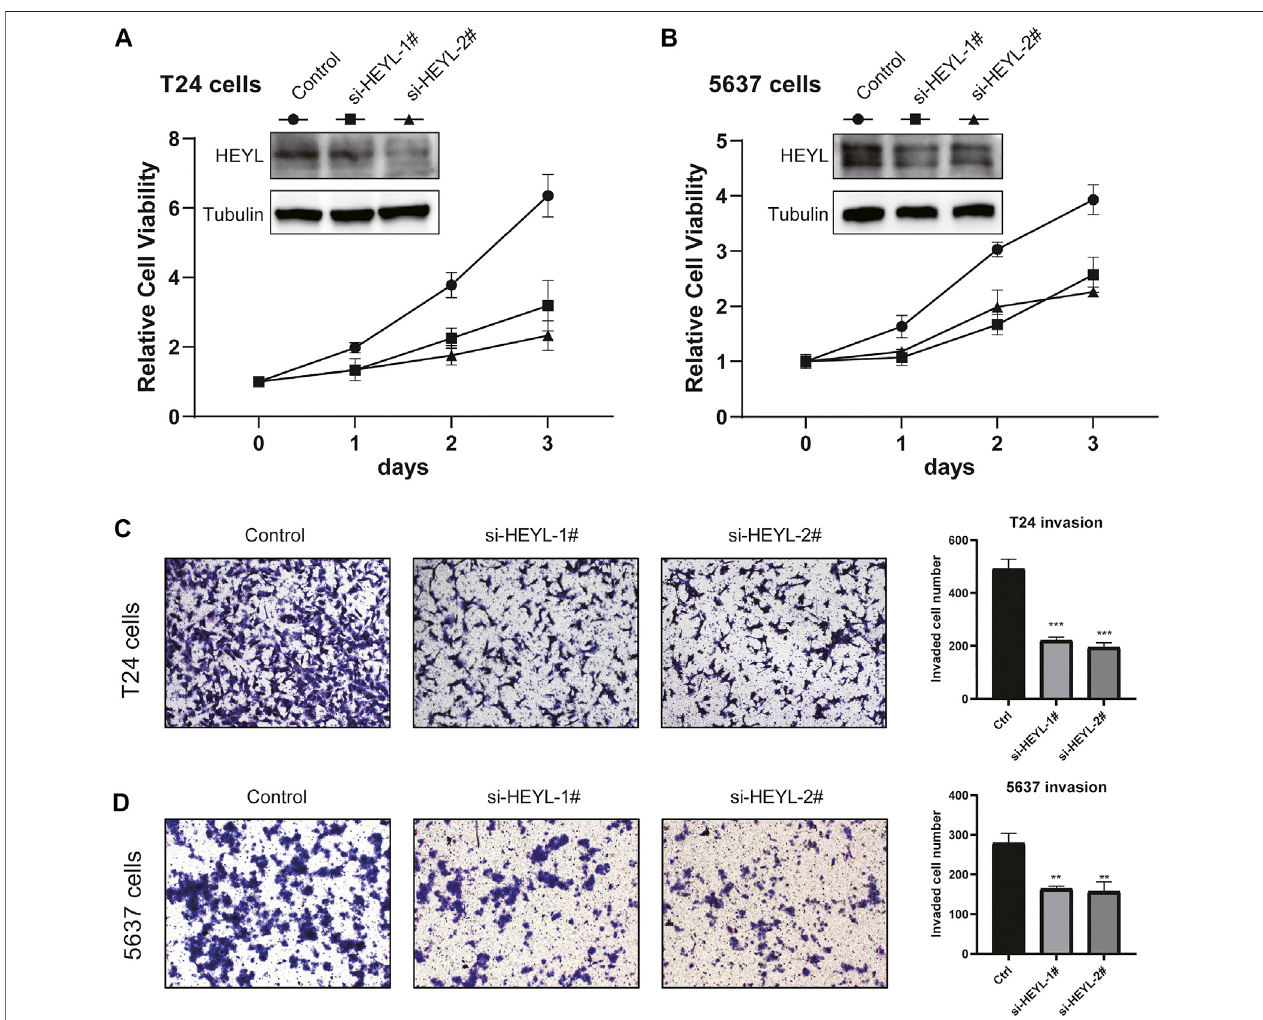
FIGURE 8 | Phenotypic validation of HEYL knockdown in BCa cell lines. (A) Knockdown of HEYL inhibited the viability of T24 cells. (B) Knockdown of HEYL inhibited the viability of 5,637 cells. (C) Knockdown of HEYL inhibited the invasion of T24 cells. (D) Knockdown of HEYL inhibited the invasion of 5,637 cells.